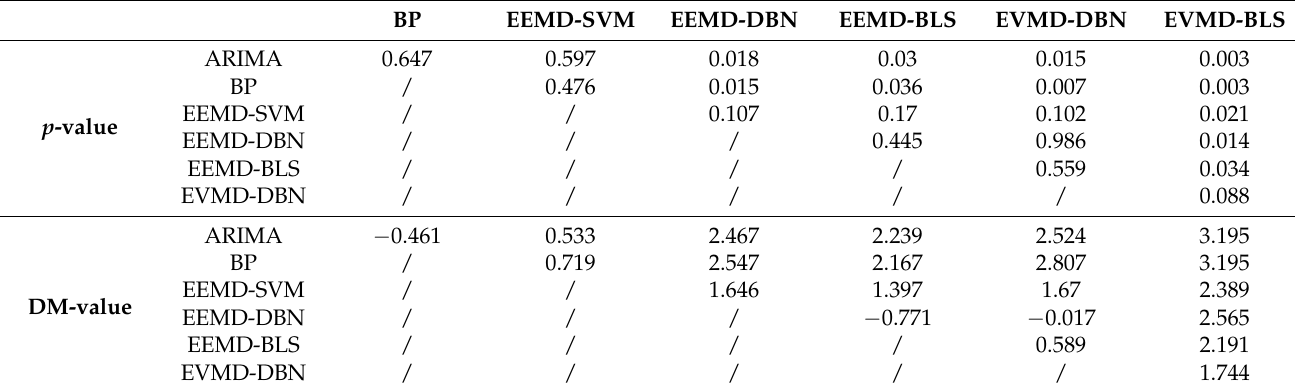
Table 3. Evaluation result of forecasting models.